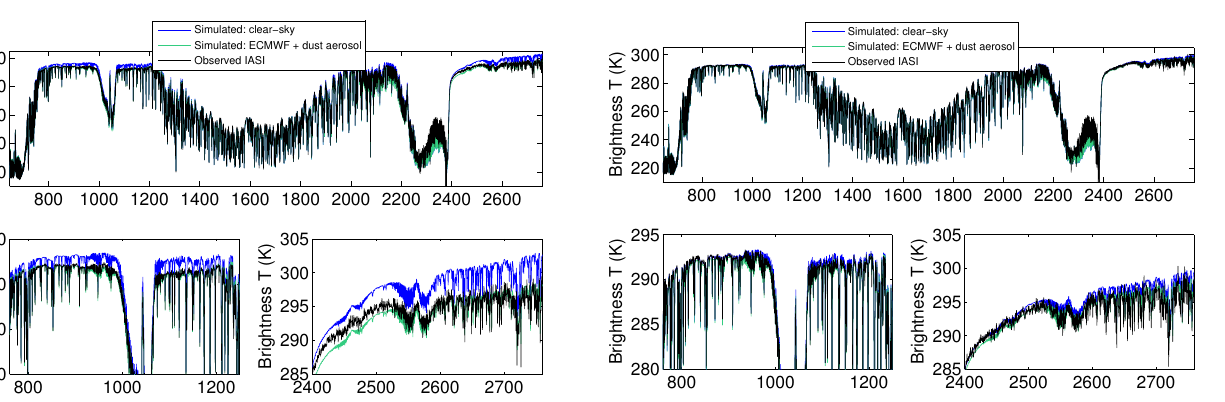
Figure 6. Sample IASI spectrum (black) acquired on 22 June (higher dust aerosol load) compared with radiative transfer simu- lations in absence (blue) and presence (green) of dust aerosol. Re- fractive indices are from Di Biagio et al. (2014).